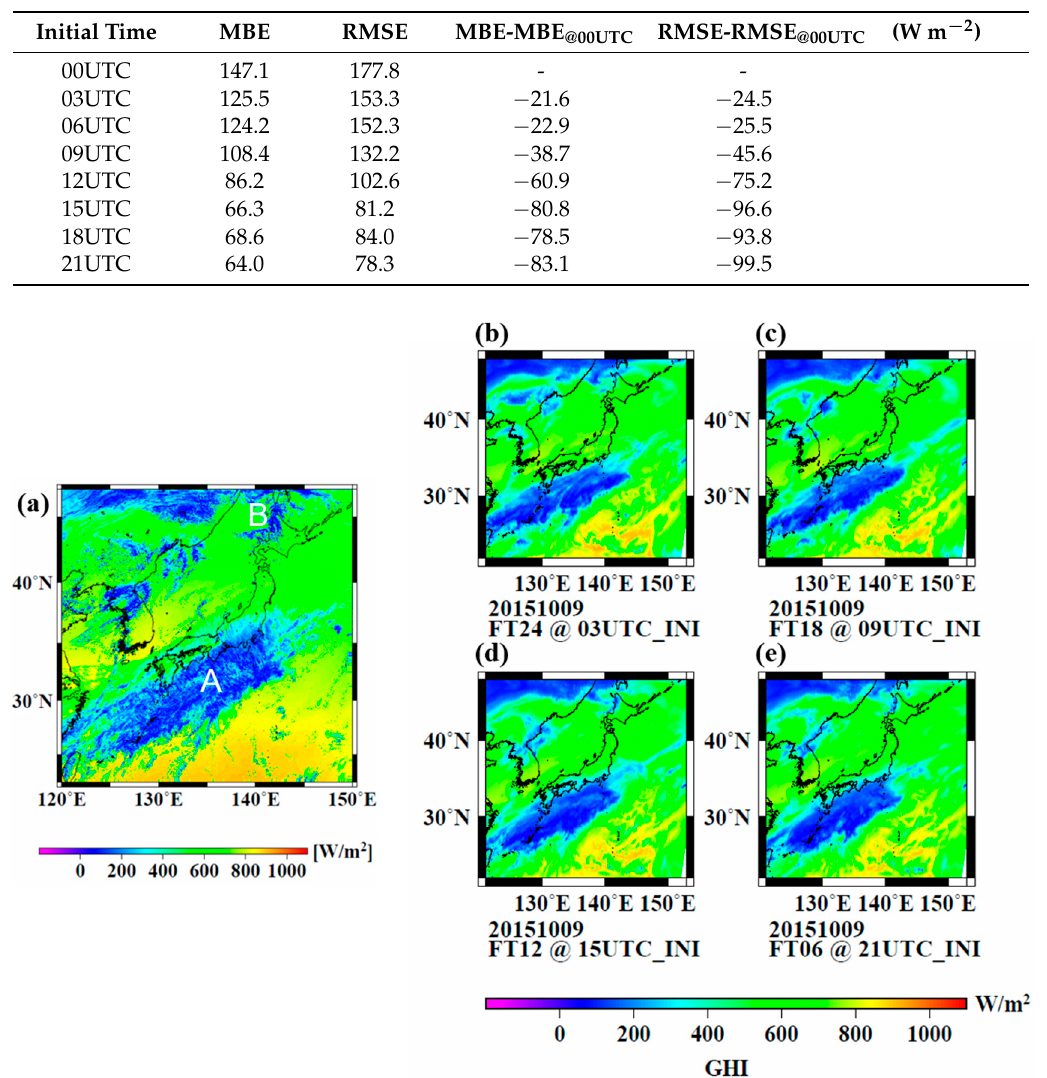
Table 7. Same as Table 6, but for 10 October 2015.